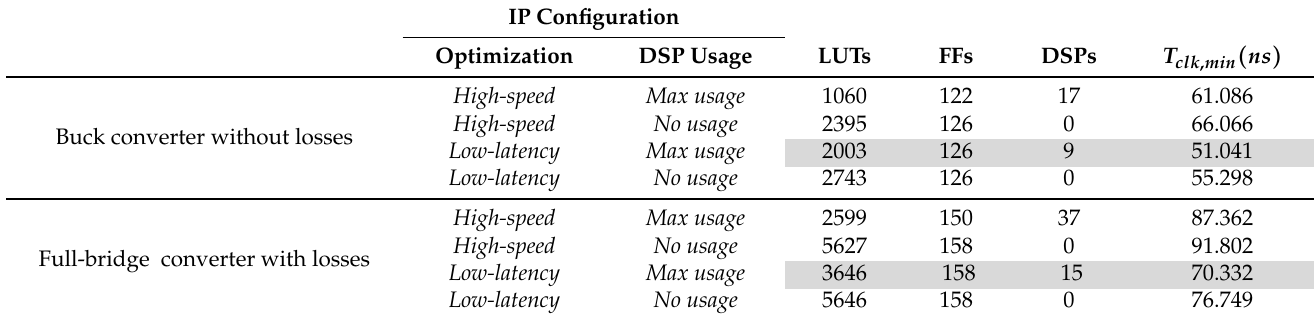
Table 1. FPGA resources used by different IP configurations and the timing